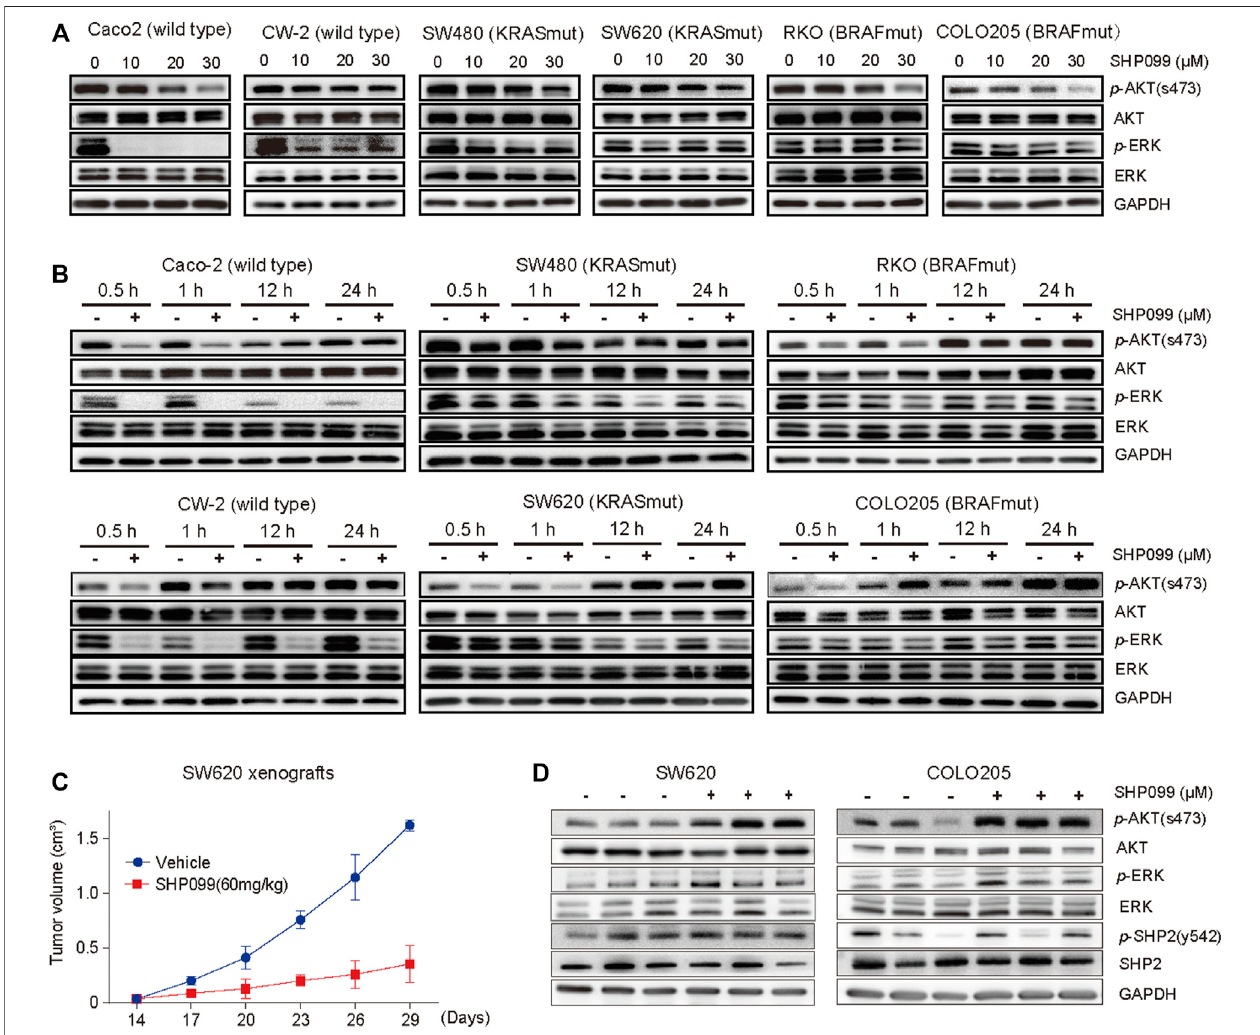
FIGURE2| FeedbackactivationofAKTsignalingfollowedbySHP2inhibitionwithSHP099inCRCcells. (A) SHP099reducestheexpressionofp-AKTinindicated CRC cells. (B) A transient inhibition of p-AKT followed by feedback activation of the signaling across all indicated CRC cells. The same cell lines treated with different concentrations of SHP099 such as Caco-2 (20 μ M), CW-2 (20 μ M), RKO (30 μ M), Colo205 (30 μ M), SW480 (30 μ M), and SW620 (40 μ M) and collected at indicated times and analyzed by immunoblotting. (C) SHP099 reduces the growth of xenograft tumors derived from SW620 cells. (D) Increased activity of p-AKT